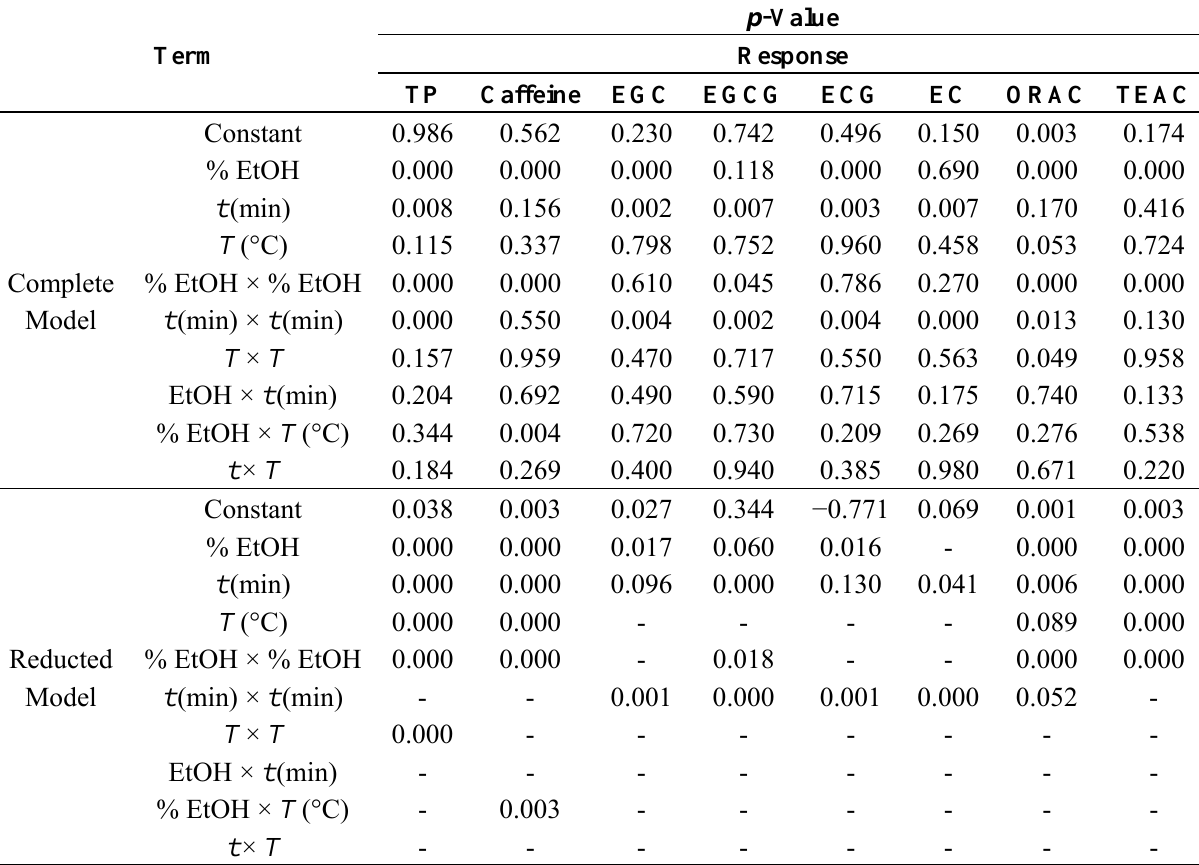
Table 3. The p -values for each of the constants in the equation of the mathematical model.